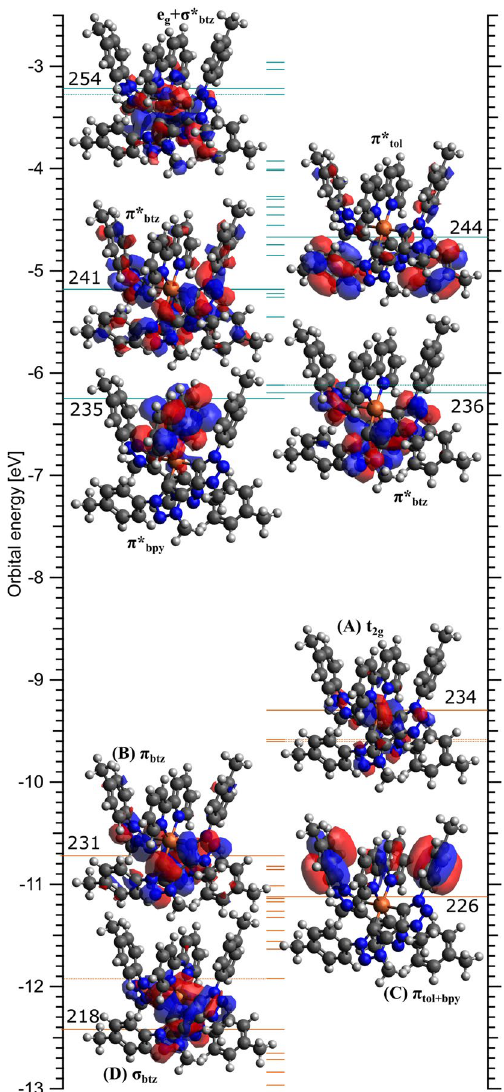
Figure 4. Energies of occupied (brown lines, orbital 234 and below) and unoccupied (turquoise lines, orbitals 235 and above) molecular orbitals (MOs) from ground state density functional theory calculations of an isolated [ Fe II ( btz ) 2 ( bpy ) ] 2 + molecule. Labels (A–D) connect to experimental features in the RPES (see text and Fig. 6). Next to each plotted MO is a description of the dominant character. Dashed lines indicate the orbital is very similar to the nearby MO that is